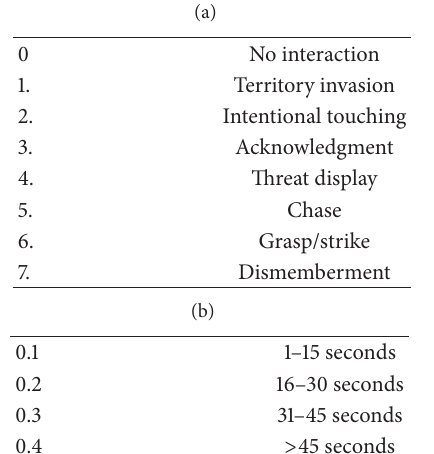
Table 1: Social interaction scoring bioindex. (a) Indicates the behavioral scoring bioindex used to quantify behavior during each trial in the experimental conditions. (b) Indicates the intensity scale based upon time duration in which the pairs were engaged in a specific